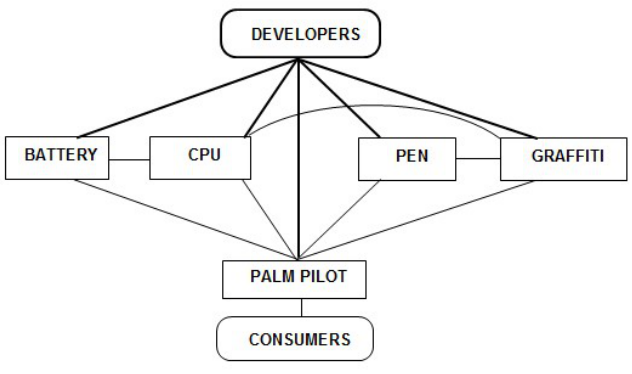
Fig. 7. Network of actors for the Palm Pilot, from the point of view of the developers and